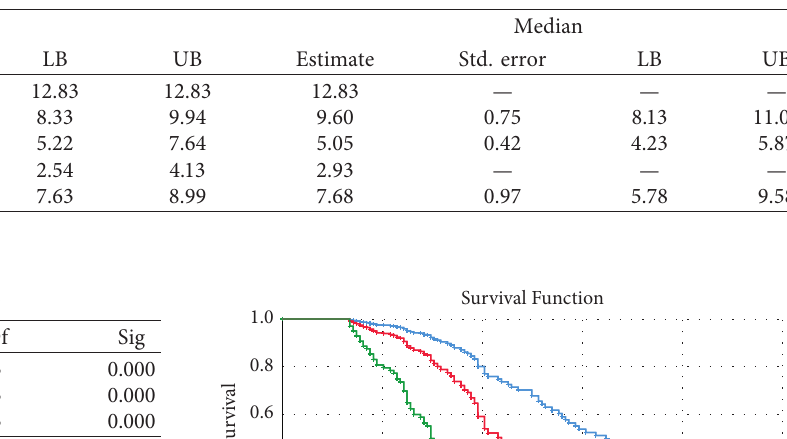
Table 6: Mean and median survival analysis times for BDCI.